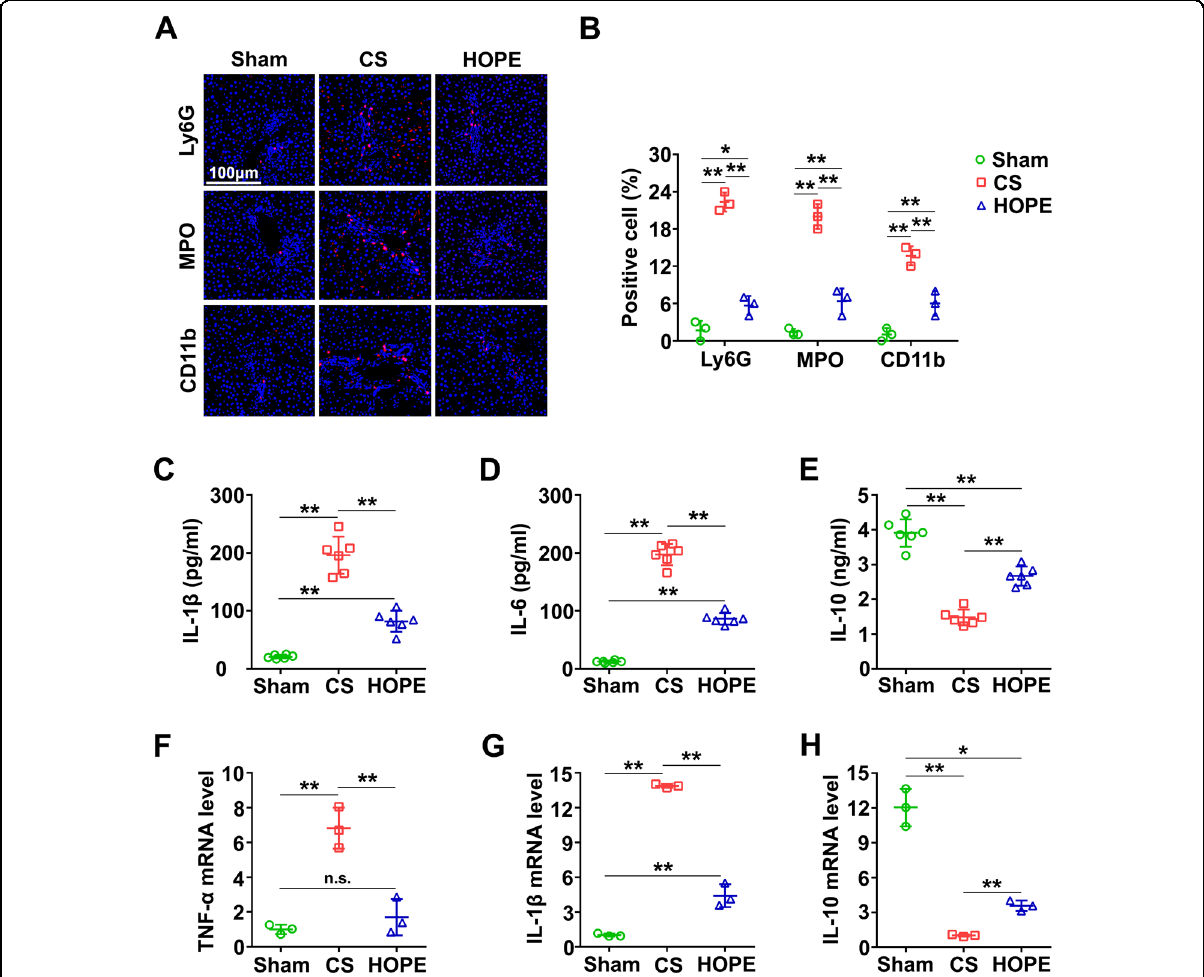
liver tissues. Scale bar = 100 μ m. B IF stained fl uorescence of Ly6G, MPO and CD11b were quanti fi ed using Image-pro plus 6.0. Data are mean ±